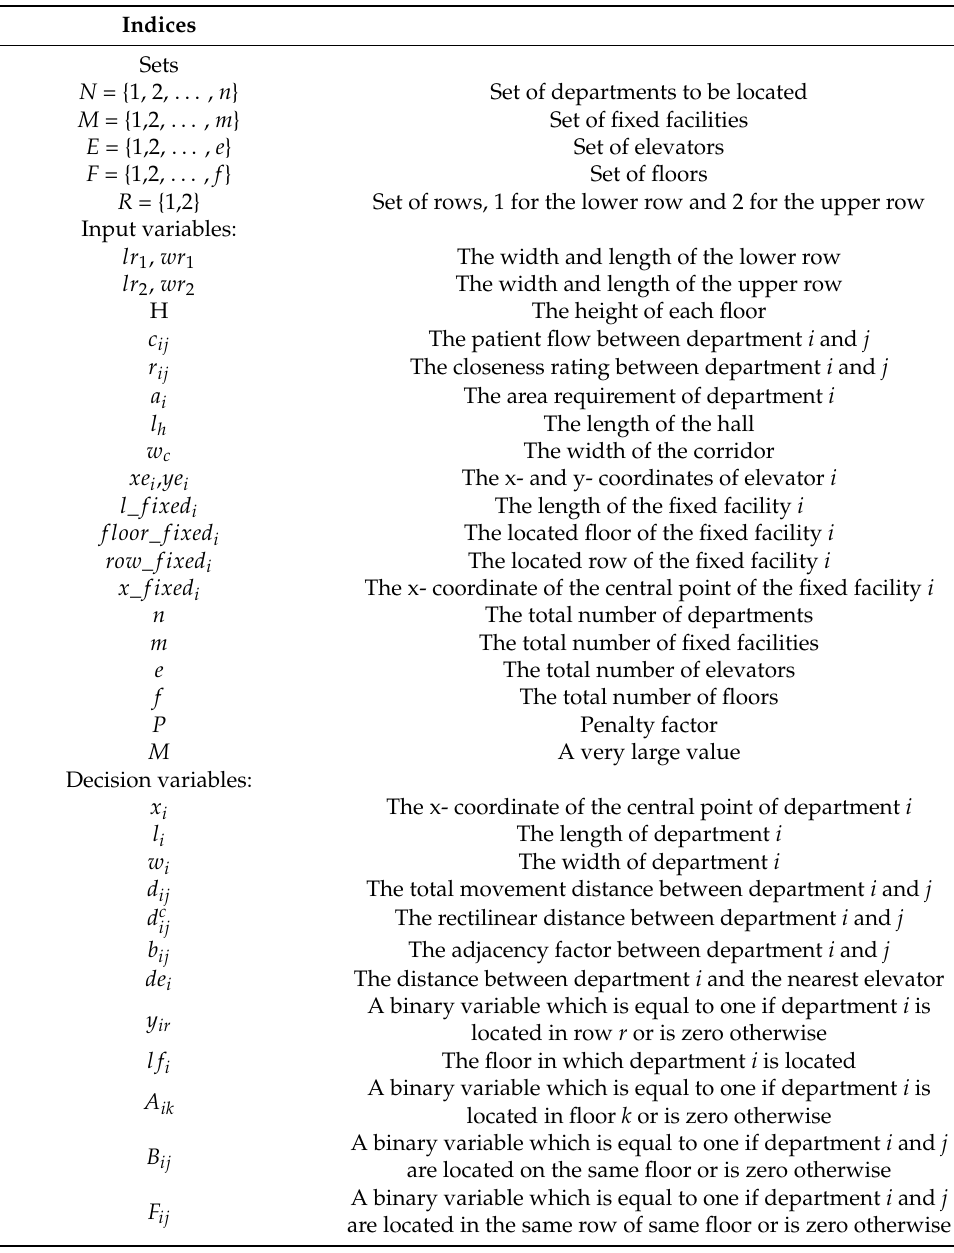
Table 1. Notations used in the